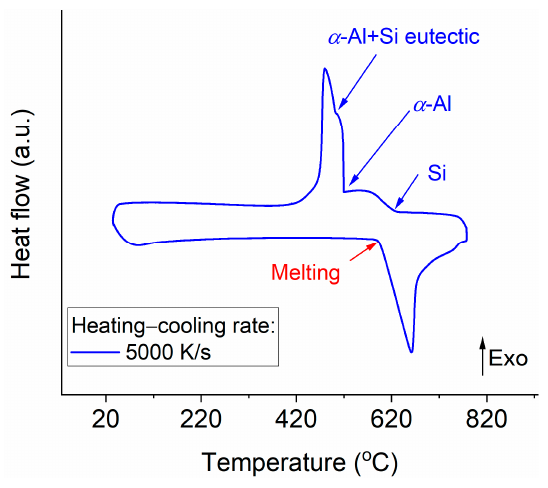
Figure 3. DFSC heat flow curve of a single Al-20Si particle (Particle I) at the cooling rate of 5000 K/s. The melting and solidification onset temperatures of different phases are indicated by arrows.